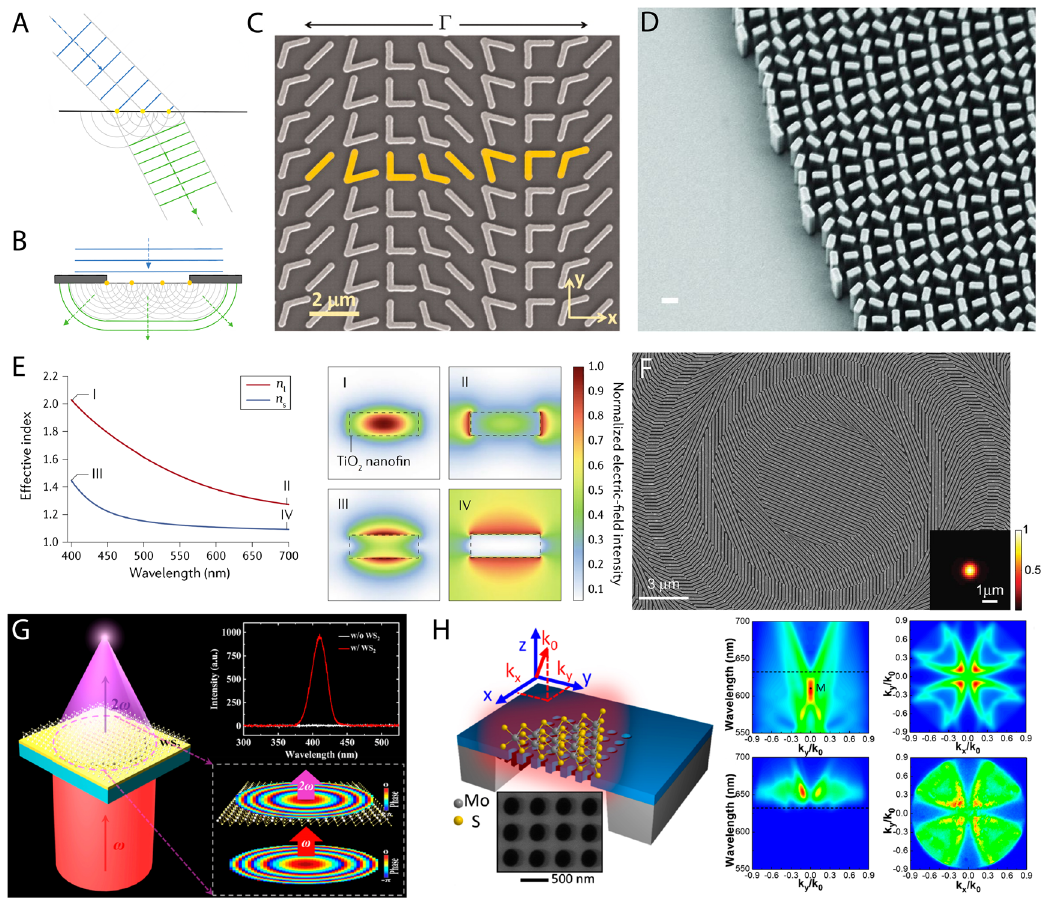
Figure 6: Phase engineering of metamaterials integrates with 2D materials. (A) and (B) Two fundamental phenomena in the field of linear-optics analyzed by the Huygens-Fresnel principle, namely refraction and diffraction, respectively. (C) The V -shape gold antenna can control the phase of transmitted light. Varying the angle of the V -shape antenna allows for precise phase manipulation [89]. (D) The TiO 2 nano fi n array with varying angle can delay different phase of the transmitted light correspondingly. The SEM image of the fabricated metalens with scale bar of 300 nm [232]. (E) A FDTD simulation of the effective refractive index of the nano fi n. Polarization of the light along long or short axis of the fi n can be supported by the fi n in different modes and leads to different effective refractive index [229]. (F) The so-called “ dielectric gradient metasurfaces optical element ” (DGMOE) using the PB phase designed. The pattern has manifested itself as the metalens that tightly focused the Incident light into a small volume ( ∼ 1 μ m) [243]. (G) A metalens can enhance and focus the second harmonic generation (SHG) signal of a WS 2 monolayer that is on its top [244]. (H) A suspended photonic crystal (PhC) wavelength selectively enhanced the PL signal of a MoS 2 monolayer on its top and changed the signal transmitted direction